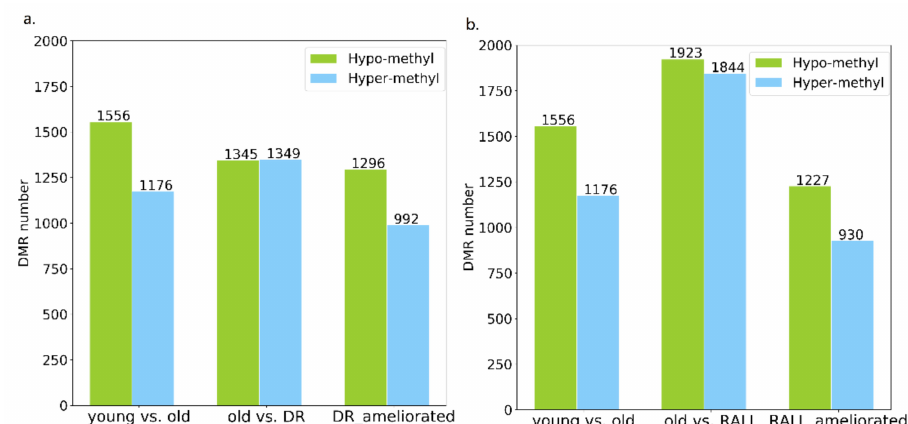
Figure 4. Number of DMRs and DR/RALL-ameliorated DMRs. ( a ) Number of aging-related DMRs, consisting of DR-related DMRs and DR-ameliorated DMRs; ( b ) number of RALL-related DMRs and RALL-ameliorated DMRs. The green bars represent the bins that were hypomethylated and the blue bars represent the bins that were